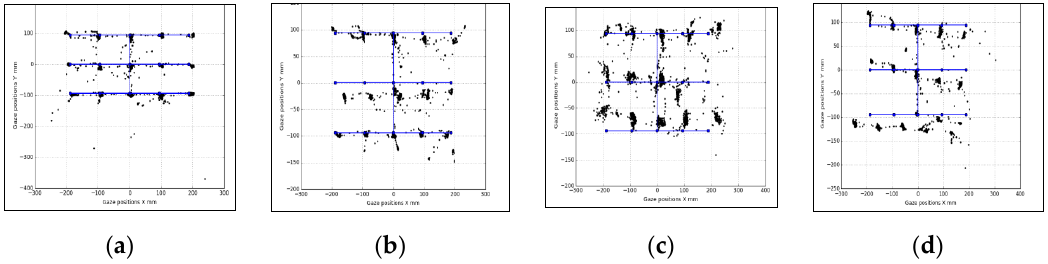
Figure 11. Data from user distance experiments: Desktop ( a ) 50 cm, ( b ) 60 cm, ( c ) 70 cm, and ( d ) 80 cm.